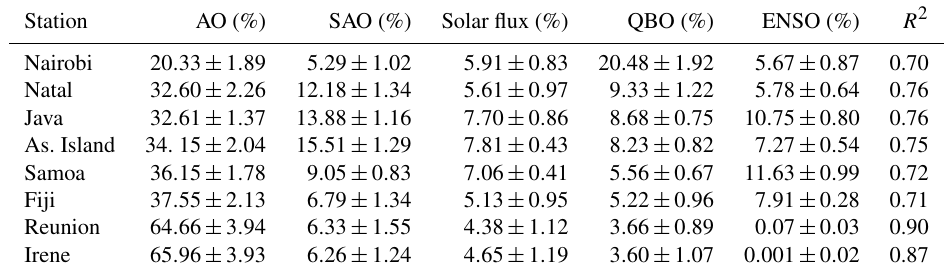
Table 4. Percentage of the contribution and corresponding SD of the annual cycle, semi-annual cycle, 11-year solar cycle, QBO and ENSO to total ozone variability for individual sites, as obtained by the Trend-Run regression model. The last column shows the corresponding value for the coefficient of determination R 2 .